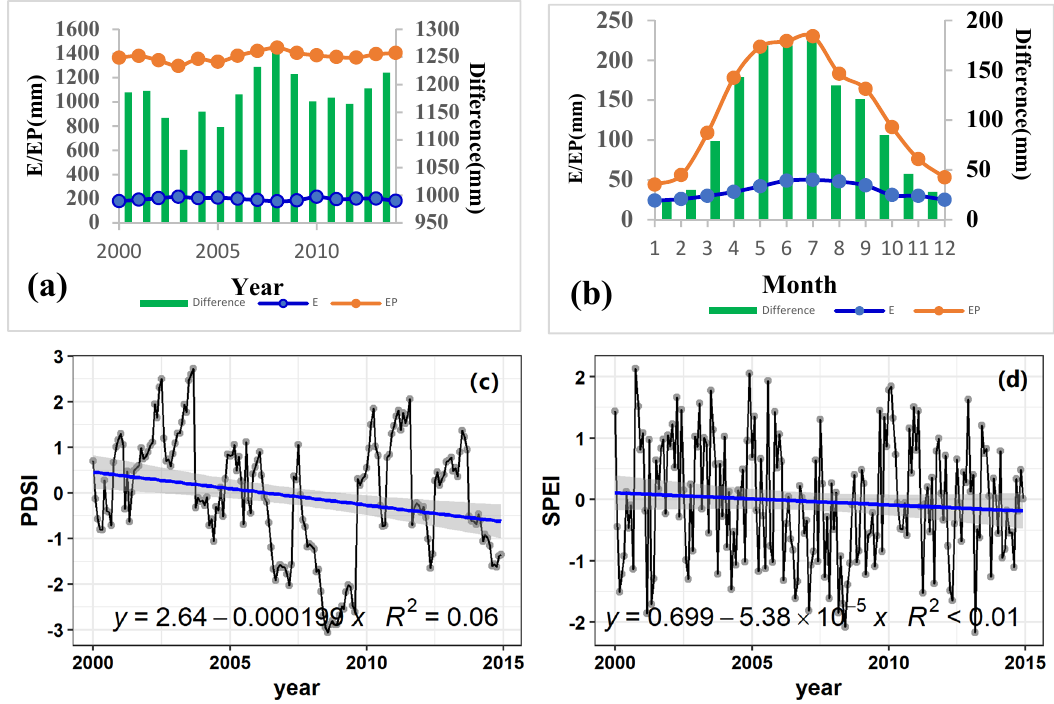
Figure 3. Annual and monthly variations of E and Ep in Xinjiang during 2000–2014. ( a ) Annual mean changes; ( b ) Monthly mean changes; ( c ) Trends of PDSI monthly scale variation; ( d ) Trends of SPEI monthly scale variation).